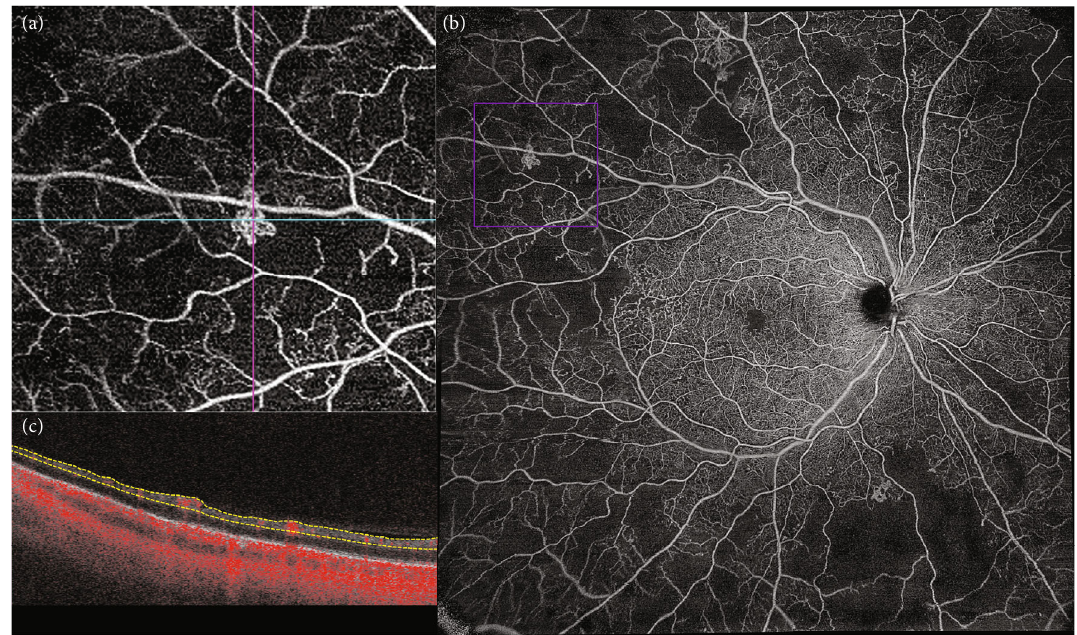
Figure 3: B-scan with slab boundaries and the corresponding fl ow en face image. (a) Wide fi eld optical coherence tomography angiography (WF-OCTA) of the posterior pole, revealing multiple areas of capillary nonperfusion and intraretinal microvascular abnormality (IRMA), outlined in the purple box. (b) Magni fi cation of the area outlined in the purple box, showing IRMA surrounded by capillary nonperfusion. (c) The intraretinal localization of the anomalous vascular network (i.e., the absence of protrusion into the vitreous) makes it possible to di ff erentiate IRMA from neovascularization elsewhere.